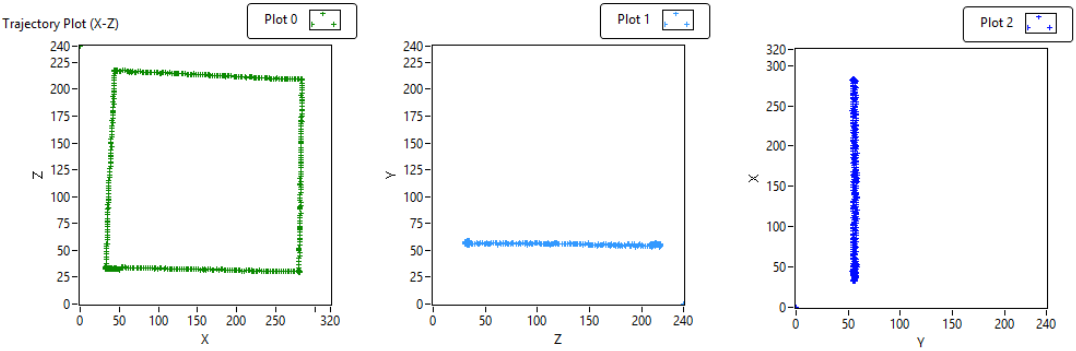
Figure 4. Square trajectory plot: Calibration tests in X-Z plane, Z-Y plane and Y-X